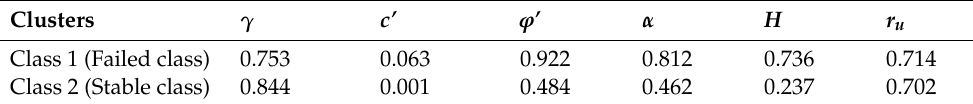
Table 4. Euclidean distance of each parameter from the centre of the concerning class. Clusters γ c’ ϕ ’ α H r u Class 1 (Failed